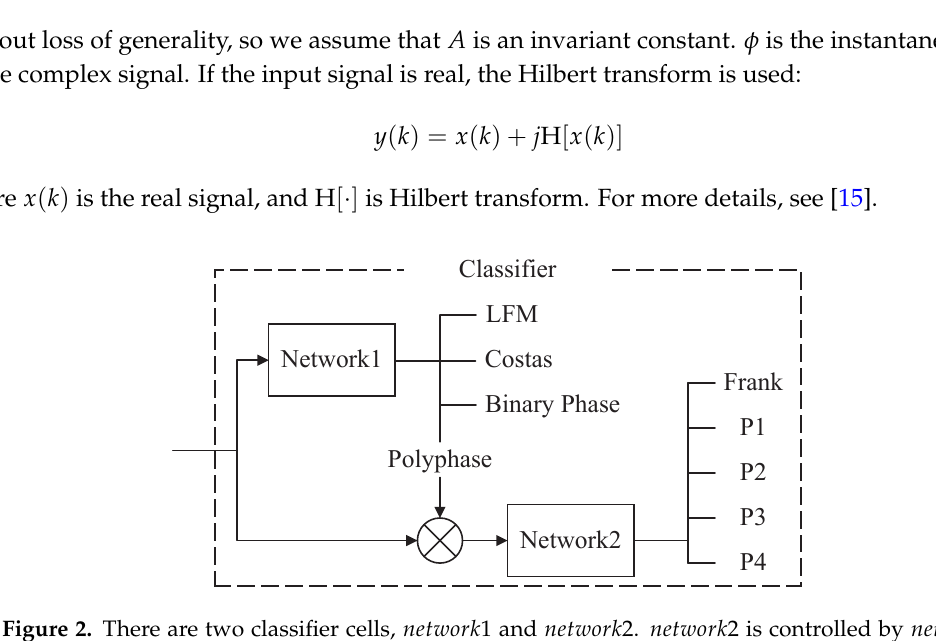
Figure 2. There are two classifier cells, network 1 and network 2. network 2 is controlled by network 1. When the recognition result is regarded as polyphase by network 1, network 2 will start to work.